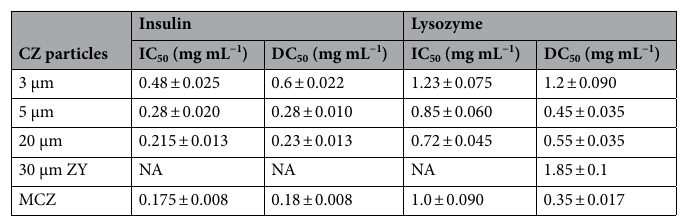
Table 1. Inhibition, IC 50 and disassembly, DC 50 values of CZ particles determined for insulin and